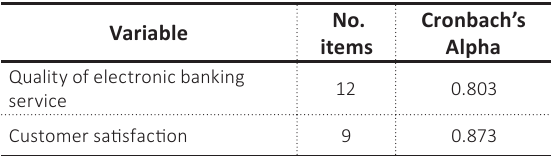
Table 1. Reliability of the research instrument